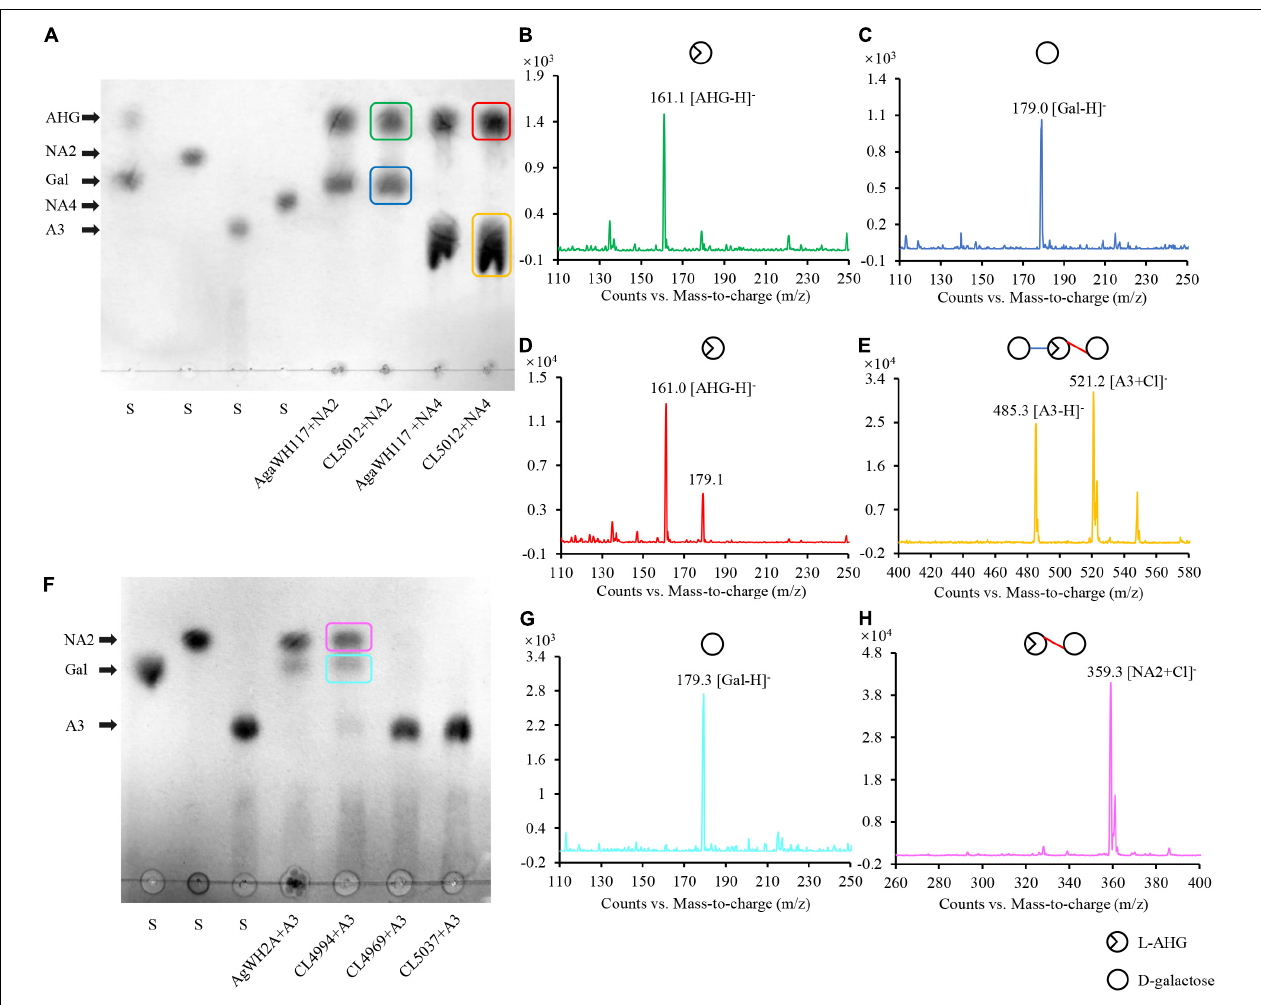
FIGURE 2 | Analysis of the reaction products of α -NAOS hydrolase CL5012 and agarolytic β -galactosidase CL4994. (A) TLC analysis of the hydrolysis products of CL5012 incubated with neoagarobiose and neoagarotetraose, respectively. (B) Mass spectrum of one spot corresponding to L-AHG. (C) Mass spectrum of one spot corresponding to D-galactose. (D) Mass spectrum of one spot corresponding to L-AHG. (E) Mass spectrum of one spot corresponding to agarotriose. (F) TLC analysis of the hydrolysis products of CL4969, CL4994, and CL5037 incubated with agarotriose, respectively. (G) Mass spectrum of one spot corresponding to D-galactose. (H) Mass spectrum of one spot corresponding to neoagarobiose. AHG, 3,6-anhydro-L-galactose; A3, agarotriose; Gal, D-galactose; NA2, neoagarobiose; NA4, neoagarotetraose; S, standard